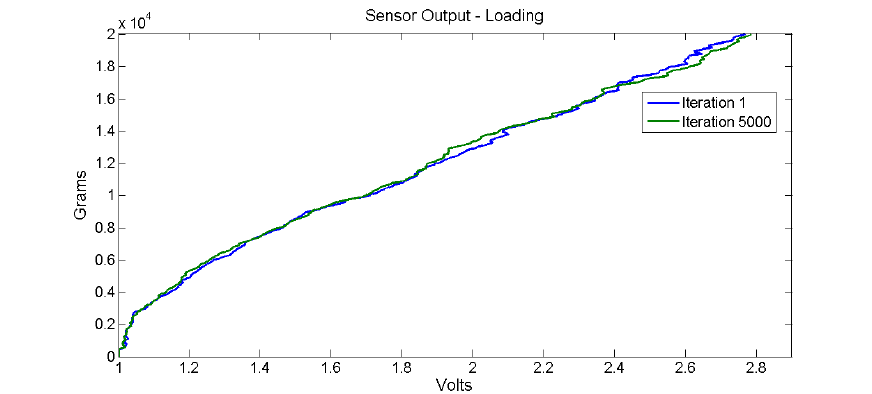
Figure 11. Raw sensor output response comparison for the loading stage.